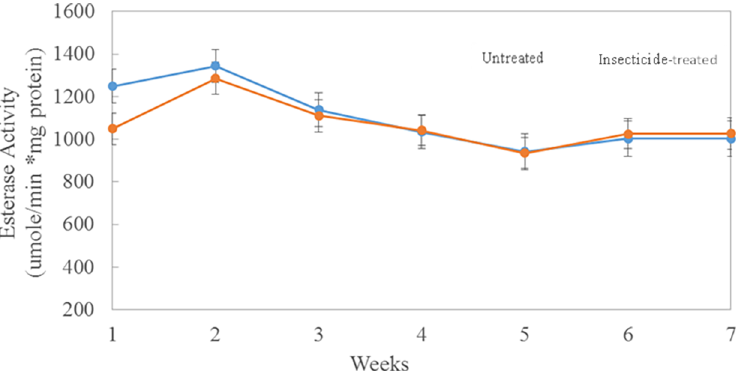
Fig 5. Esterase activity from bees collected weekly from five insecticide-treated (orange line) or–untreated (blue line) sites. Points represent mean activities (μmole/min (cid:3) mg protein; ± SEM) from triplicate assays of 10 bees collected from 3 colonies from each treated or control